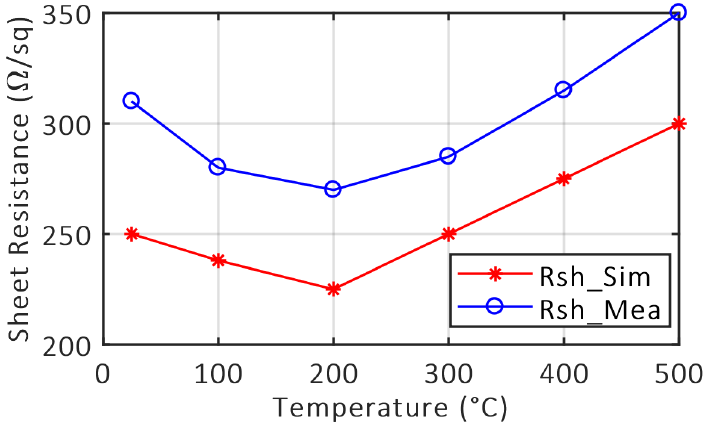
Figure 9. Simulated and measured sheet resistance over the wide temperature